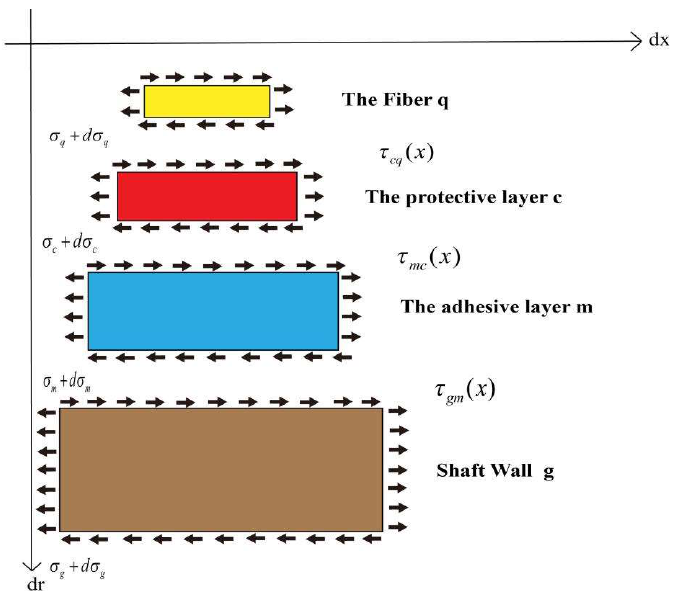
c r  .Analysis of the forces on each